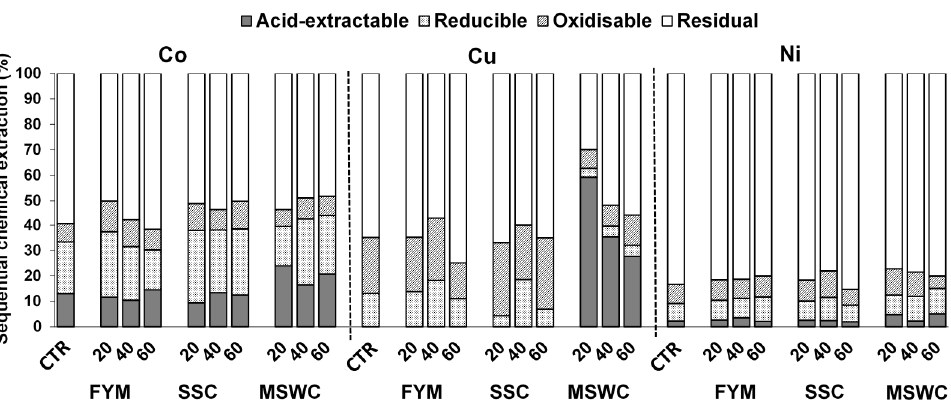
Figure 4. Sequential chemical extraction of Co, Cu and Ni of control soil (CTR) and soils amended with different doses (20, 40, 60 t ha − 1 ) of farmyard manure (FYM), sewage sludge compost (SSC) or municipal solid waste compost (MSWC).